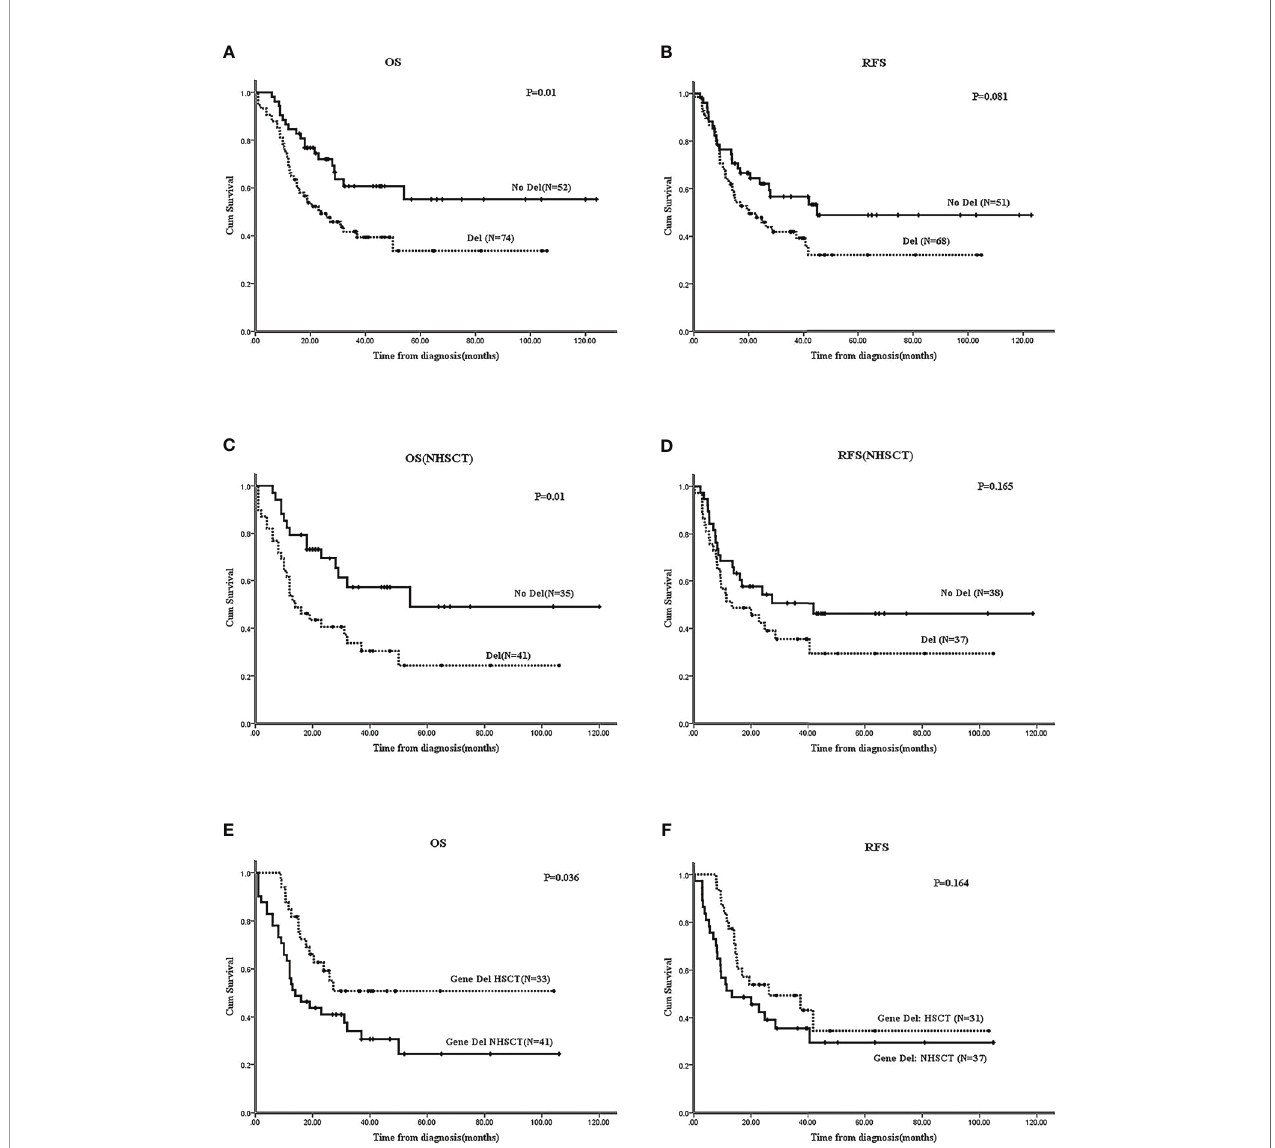
FIGURE 2 | Effect of gene deletions on survivals of Ph - B-ALL patients by Kaplan-Meier plots. (A, B) The 2-year OS and RFS of Ph - B-ALL patients who carried gene deletion vs. none gene deletion. (C, D) The 2-year OS and RFS of Ph - B-ALL patients who carried gene deletion vs. none gene deletion in no HSCT group (NHSCT: No HSCT). (E, F) The 2-year OS and RFS of Ph - B-ALL patients with gene deletions who received HSCT vs. who didn ’ t receive HSCT. Note: In all the RFS analysis of this study, 6 Ph-B-ALL patients received HSCT at CR2, the 6 patients were analyzed in non-HSCT group, and 9 patients who didn ’ t receive CR were also excluded from RFS